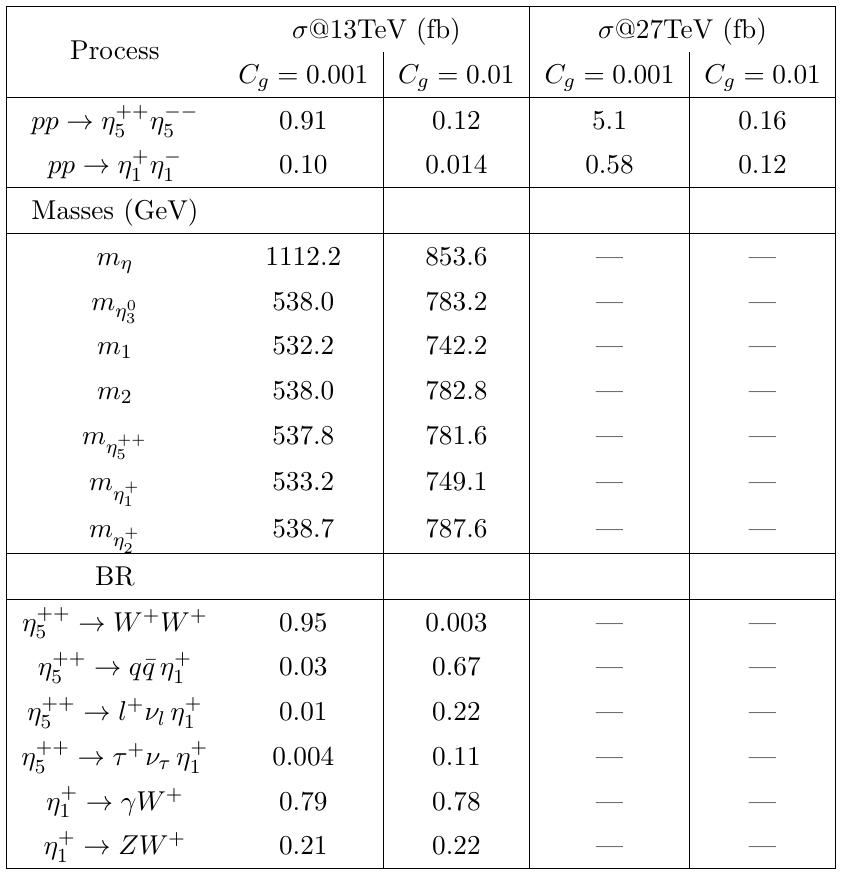
p s = 13 and 27 TeV for two benchmark decays, including chain decays 5